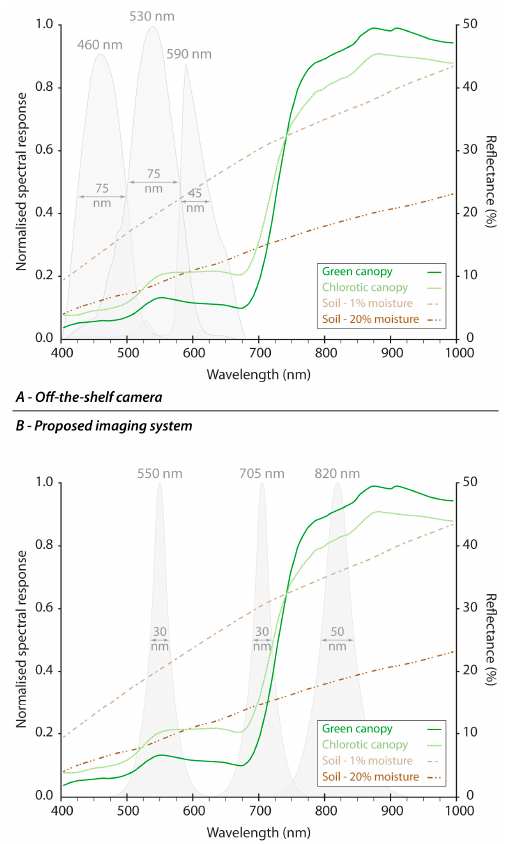
Figure 3. The spectral reflectance curves of a green and a chlorotic vegetation canopy along with those of a soil (circa 20% sand, 70% silt, 10% clay) with varying degrees of moisture: ( A ) How a common DSC would sample these curves, while the lower part; and ( B ) The spectral transmission of the proposed interference filters in relation to these spectral reflectances. All spectral channels have their wavelength of maximum transmission and their bandwidth in terms of full-width at half-maximum indicated.